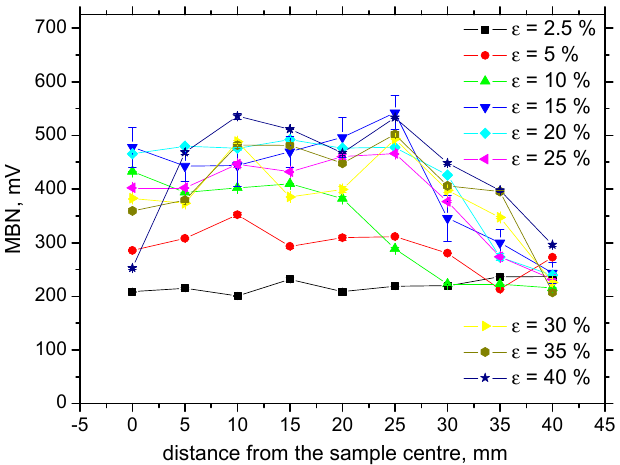
Figure 13. Evolution of MBN along with ε , TD.